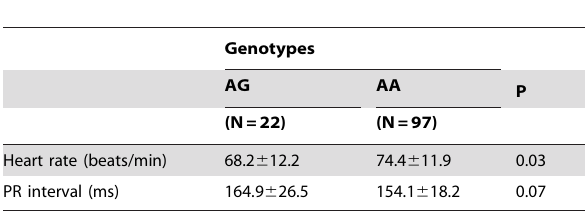
Table 4. Effects of AGT G-6A polymorphism on heart rate and PR interval measured by ECG recordings in control patients without